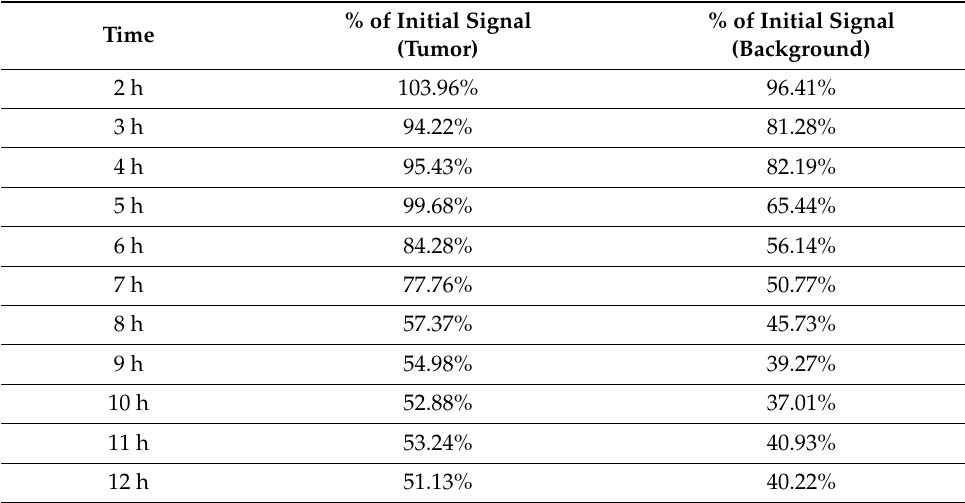
Figure 1. ( A ) Images of subcutaneously implanted patient-derived xenografts of pancreatic cancer after intravenous injection of aCEA-nb800 over the 12 timepoints measured using the LICOR Pearl small animal imager. The red arrow indicates the tumor and the yellow arrows with dashed lines indicate the kidneys. ( B ) Maximal fluorescence intensity of tumor, kidney, and background plotted over time. ( C ) Calculated tumor-to-background ratio from the tumor is plotted over time. Error bars indicate standard error. Table 1. The rate of decrease of maximal fluorescence intensity was compared over time for tumor and background. The initial signal at 1 h was compared to all other subsequent time points as a percentage of original and tabulated below.